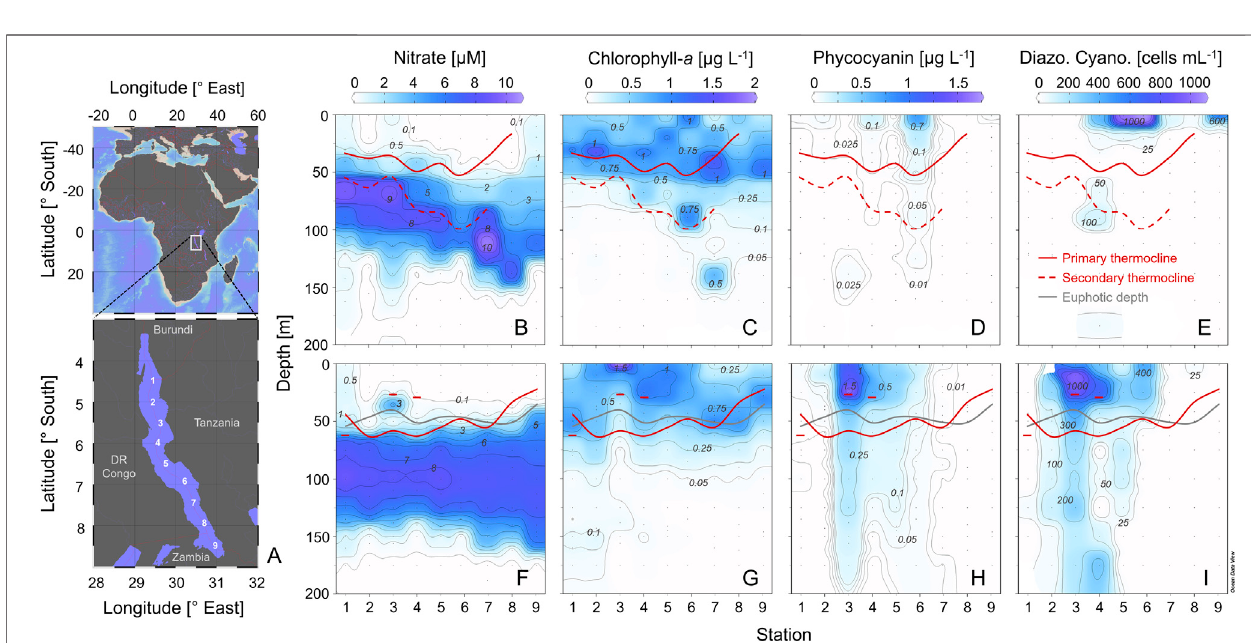
FIGURE 2 | Map of Lake Tanganyika showing the 9 sampling stations in a north-south transect (A) . Distribution of the nitrate (B, F) , chlorophyll- a (C, G) , and phycocyanin concentrations (D, H) , as well as the cell abundance of fi lamentous diazotrophic cyanobacteria (E, I) in Lake Tanganyika. The colored lines depict the locationsoftheprimarythermoclineandtheeuphoticdepthaswellasshallowanddeepsecondarythermoclines.Theupperpanelscorrespondtotheendofthecooldry season (September/October 2017) and the lower panels to the end of the more strati fi ed, warm rainy season (April/May 2018). Dots indicate samples.